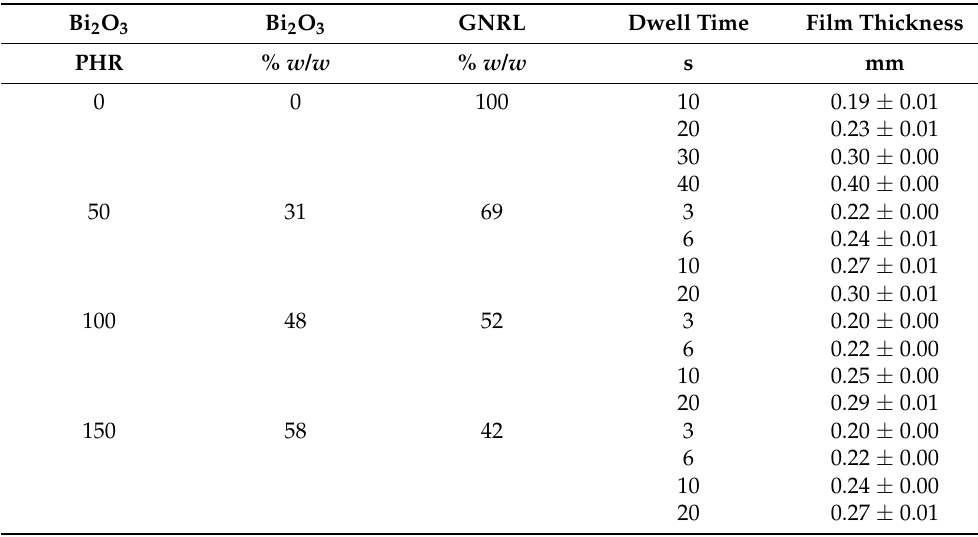
Table 4. Prepared GNRL/Bi 2 O 3 films by dipping with different weight fractions (wt %) of attenuating filler and GNRL, dwell time, and film